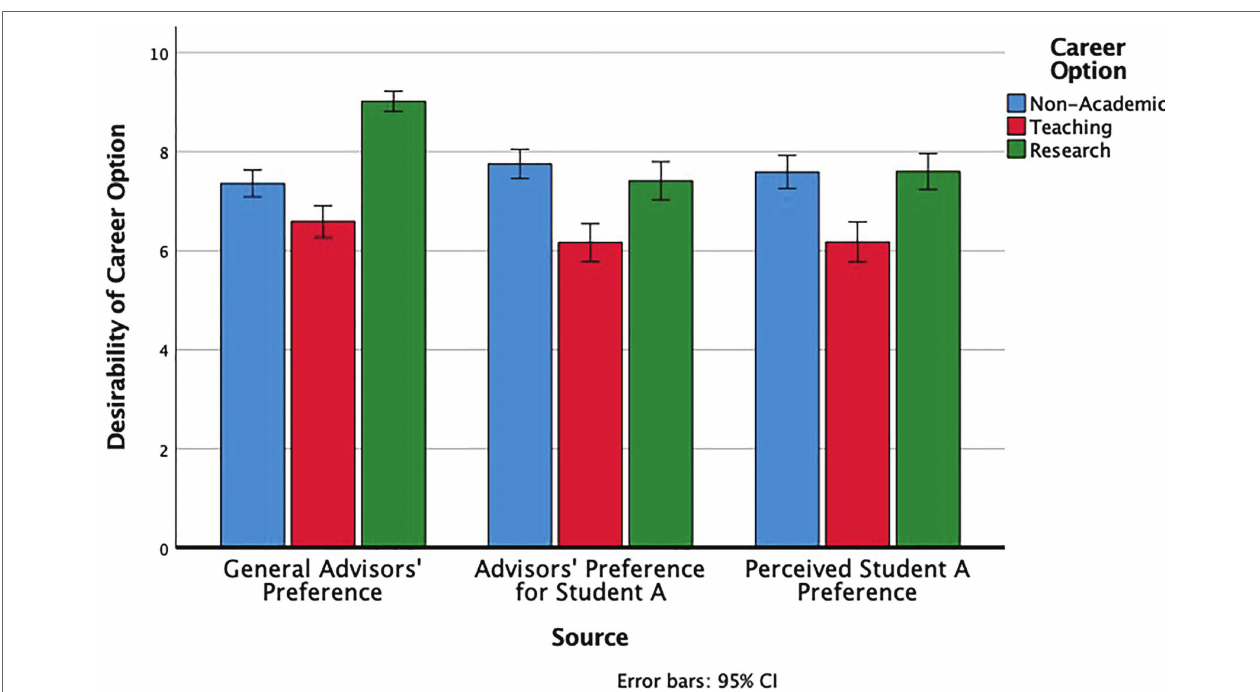
FIGURE 5 | Advisors’ general desirability ratings for each career option (left) , desirability ratings for each career option for Student A (their most senior PhD student; middle ), and their perception of Student A’s desirability ratings for each career option (right) .